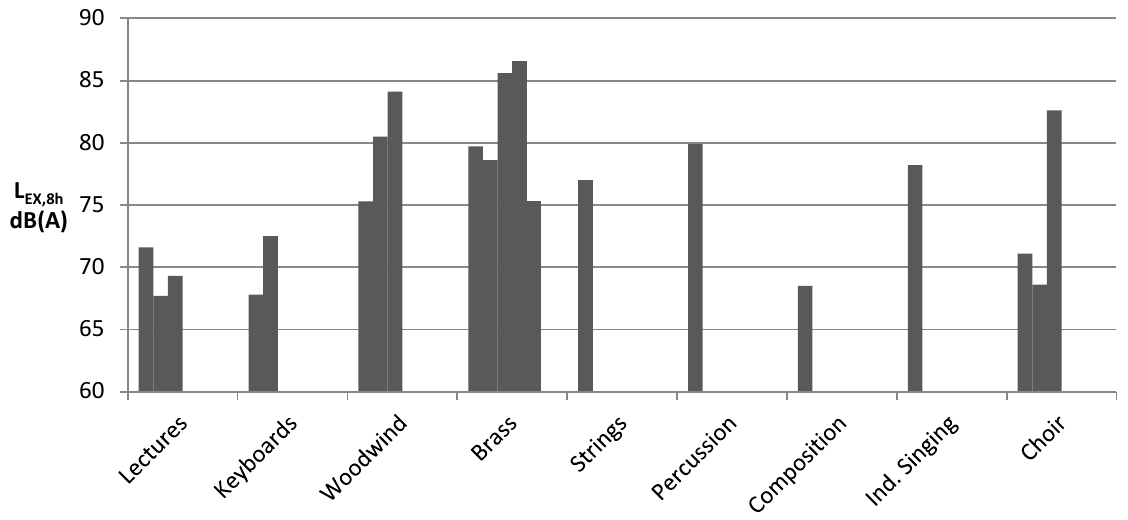
Figure 2. Daily noise exposure according to the category of instruments played and class